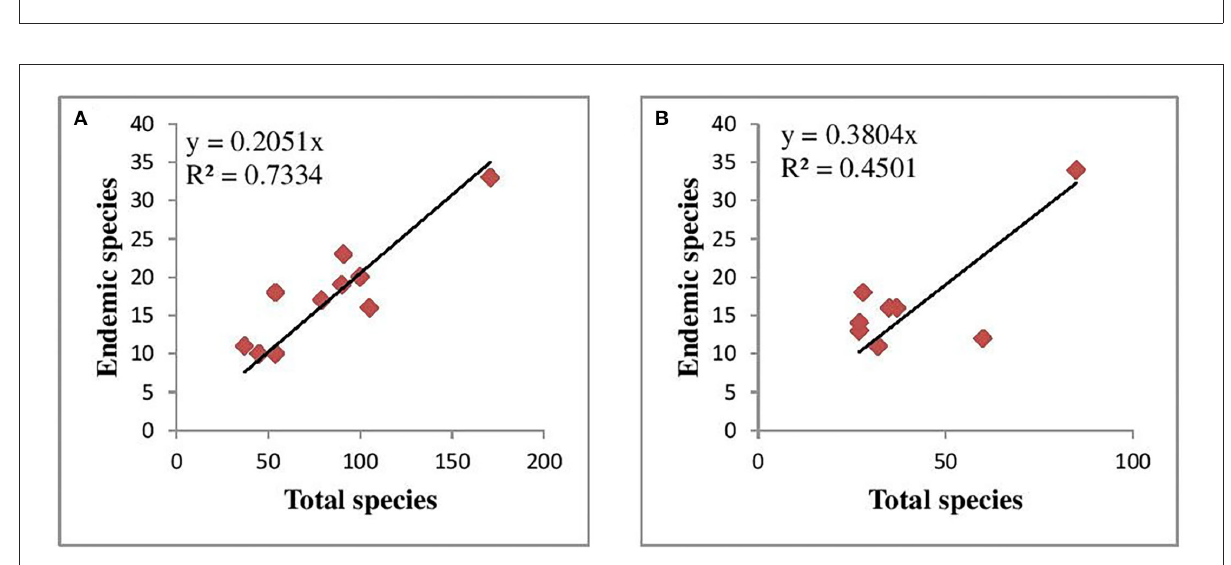
FIGURE4 Correlation between total species and native species (A) forest zone (B) alpine zone.